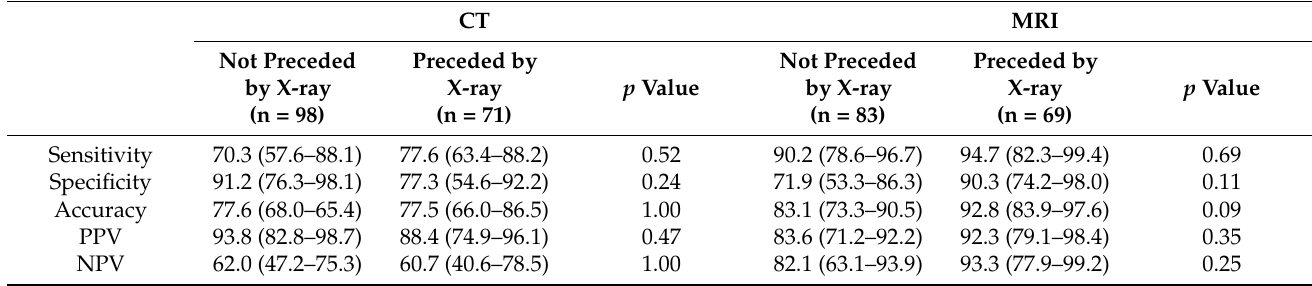
Table 5. Sensitivity, specificity, accuracy, PPV and NPV estimates (reported with 95% confidence intervals) for CT and MRI without or with access to a preceding